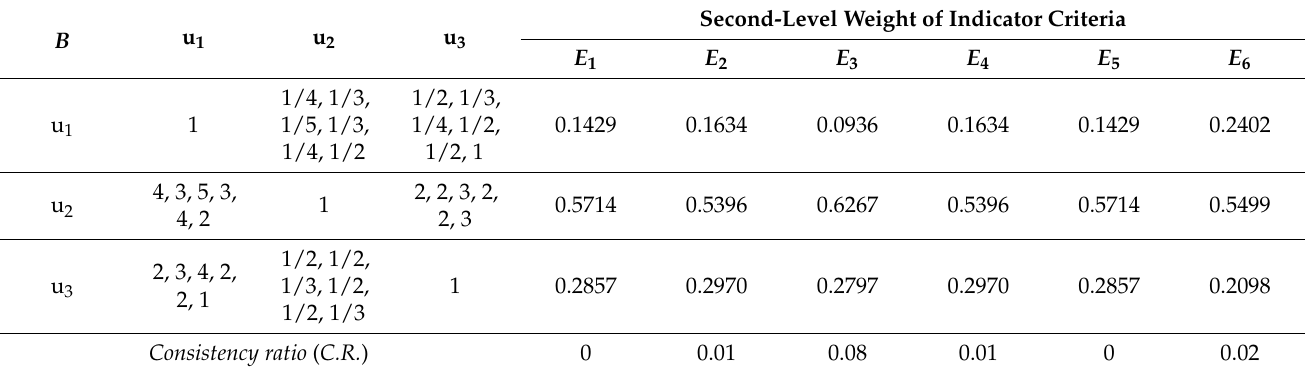
Table 9. Judgment of six experts’ scoring for the importance of core patent value indicators.